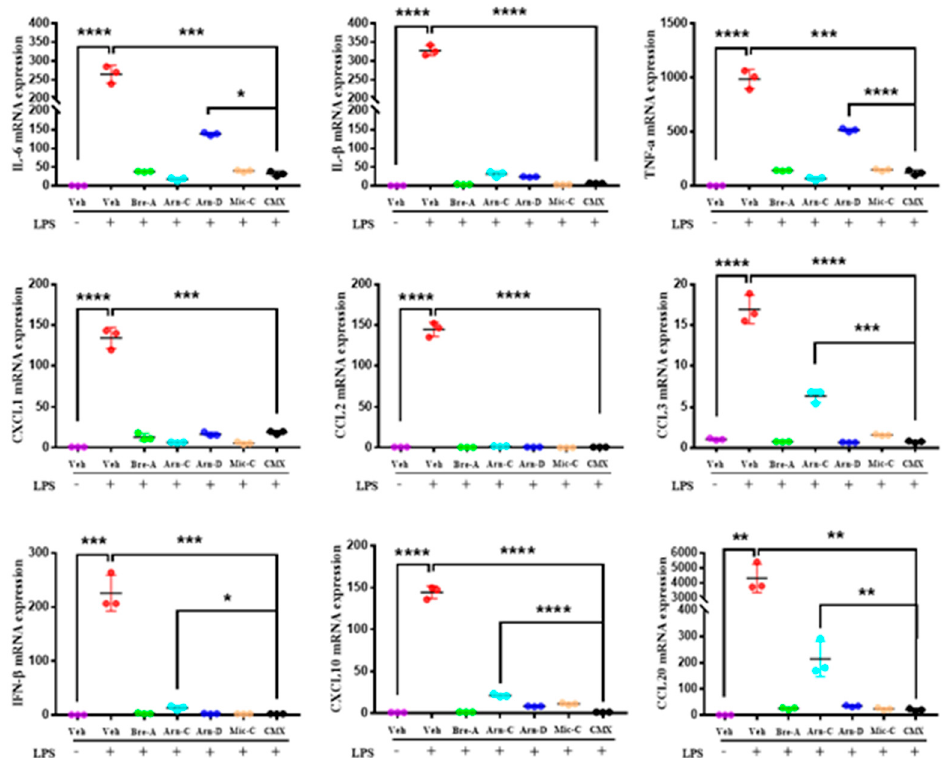
Figure 3. CMX inhibits pro-inflammatory factors production in macrophages induced by LPS. The mRNA expression of IL-6, IL-1 β , TNF- α , CXCL1, CCL2, CCL3, IFN- β , CXCL10, and CCL20 were detected in macrophages by RT-qPCR. Relative mRNA expression levels were normalized to mouse GAPDH levels. The data were expressed as means ± sem. * p < 0.05, ** p < 0.01, *** p < 0.001, **** p < 0.0001. Three repeated trials were presented per group ( n = 3). All concentrations of mixtures or components are 3 µg/mL. Bre-A, Brevilin A; Arn-C, Arnicolide C; Arn-D, Arnicolide D; Mic-C, Microhelenin C; CMX, emulsion extract from Centipeda minima .